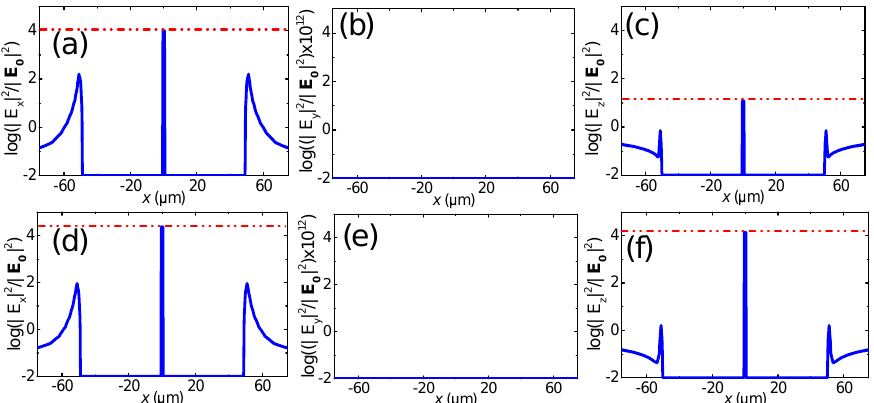
Figure 4. Electric field components E x , E y , E z at y = 0 and z = 1.2 µ m, highlighting the totally negligible E y component and the field enhancement in the